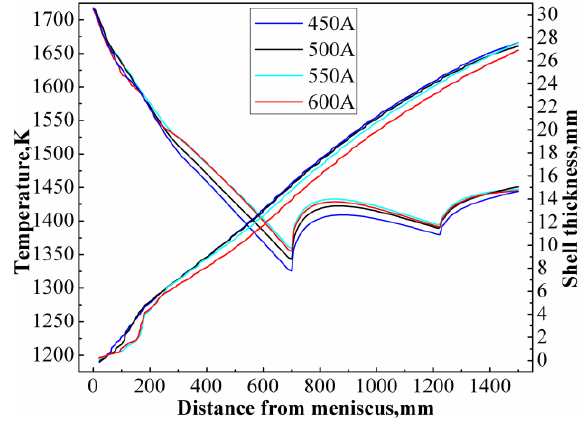
Figure 18. Variation of surface temperature and shell thickness along with casting direction at different current intensities.